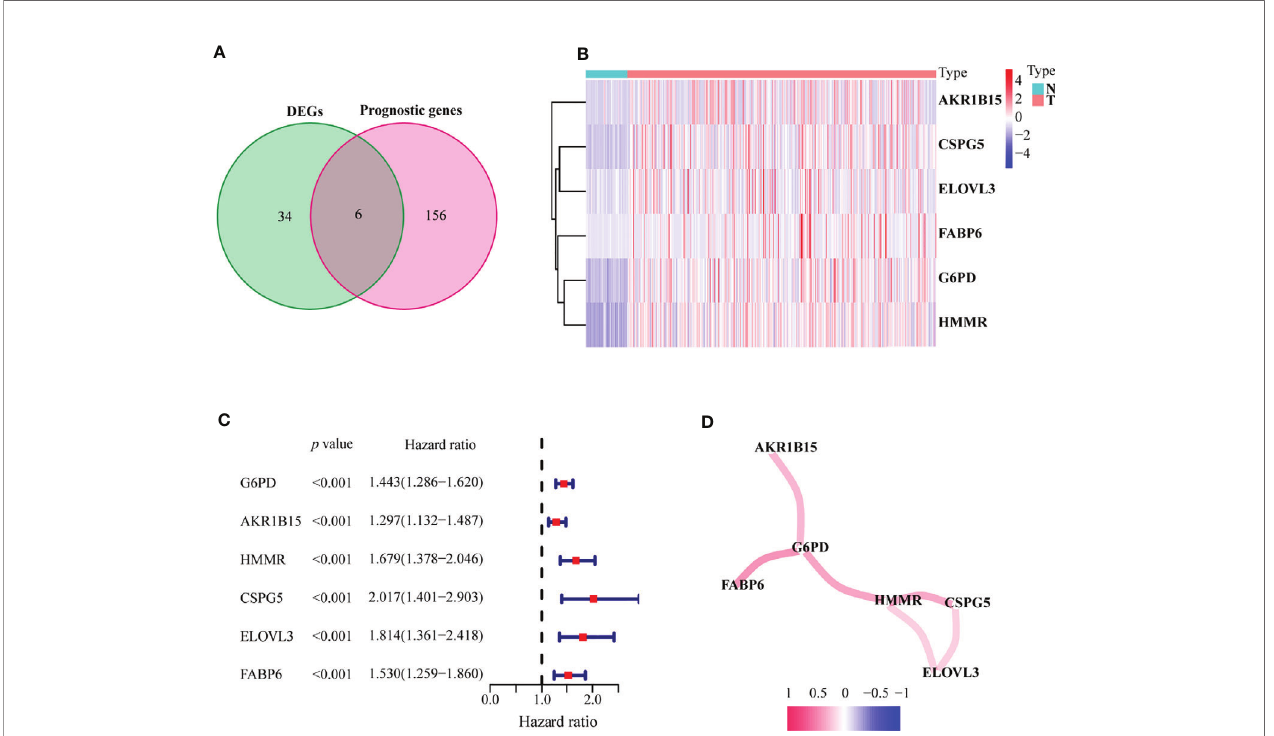
FIGURE 1 | Identi fi cation of the candidate metabolism-related genes in the TCGA set. (A) Venn diagram to identify prognostic DEGs between tumor and adjacent normal tissue. (B) The heatmap of the six genes between tumor and adjacent normal tissue. (C) The forest plot between gene expression and OS. (D) The correlation network of six metabolism-related